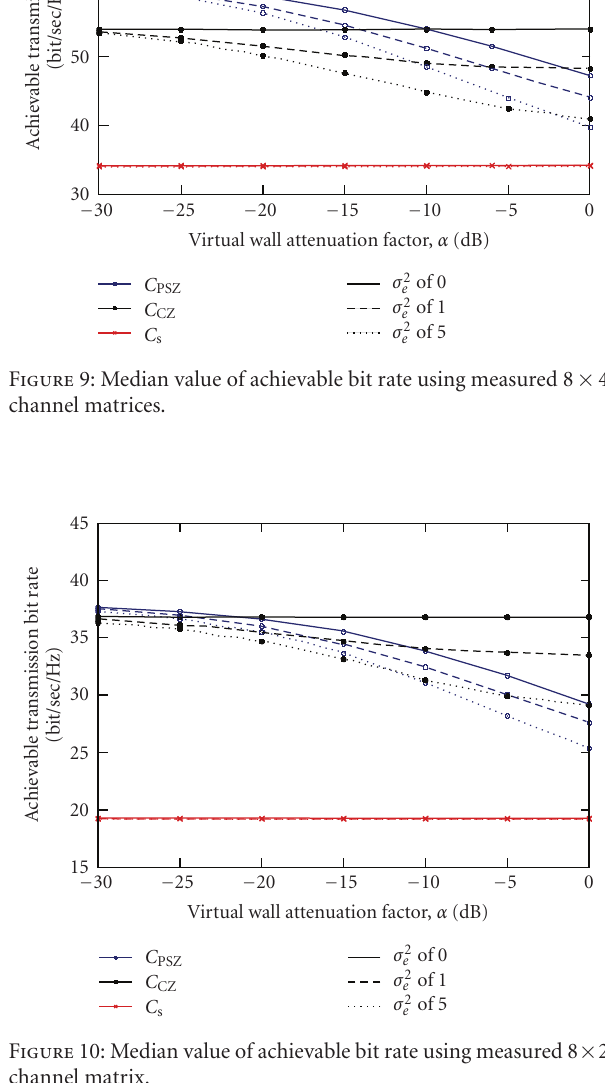
Figure 8: CDF of achievable bit rate using measured 8 × 2 channel matrix with α = 0.